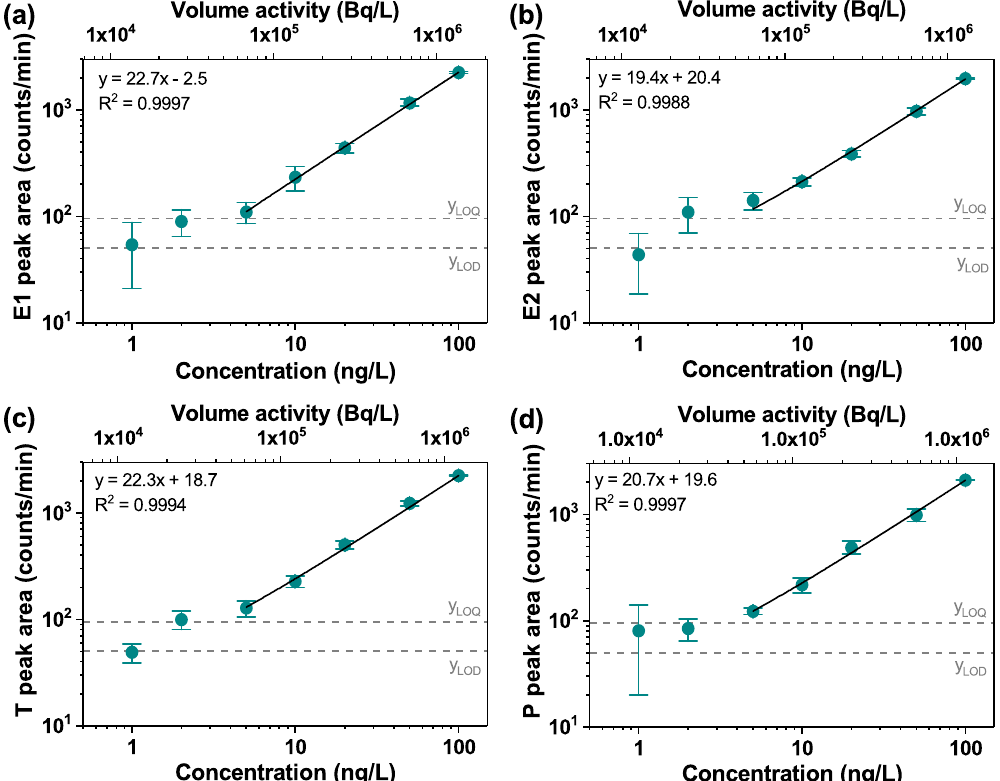
Figure 4. Calibration curves of ( a ) E1, ( b ) E2, ( c ) T and ( d ) P. The error bar was calculated as maximum error based on at least four repeats. The fitting (solid line) was performed in linear coordinates. The estimated peak areas at the limit of detection ( y LOD ) and the limit of quantification ( y LOQ ) were demonstrated as dashed lines. The details on the estimation of activity at LOD are given in Supplementary Information.